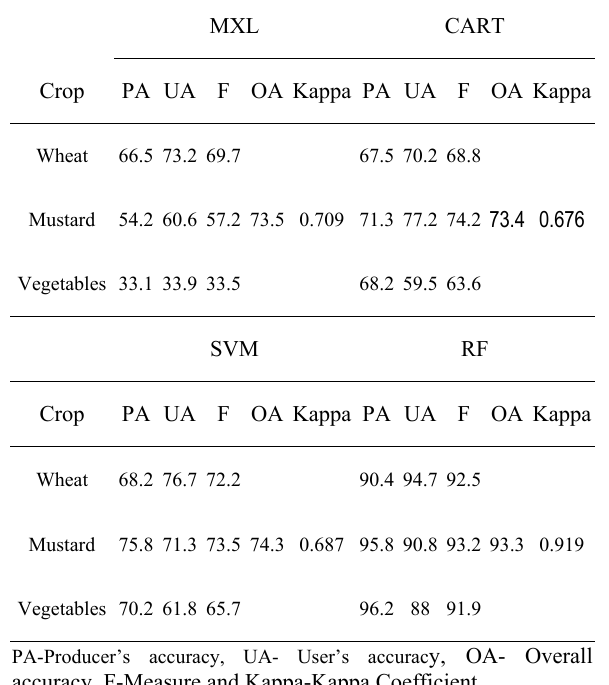
Table 4. Comparison of accuracies of MXL, CART, SVM and RF based classification